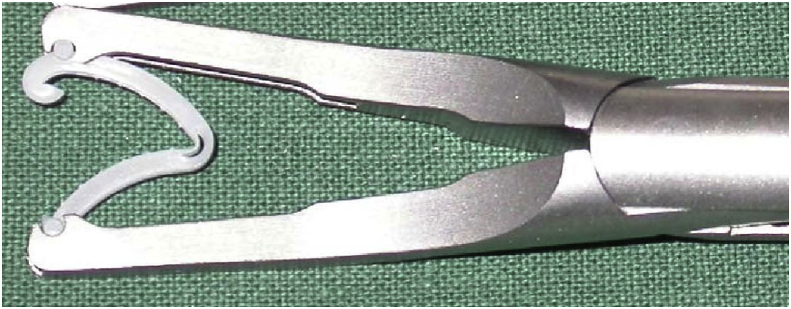
Hem-o-lok stapling.